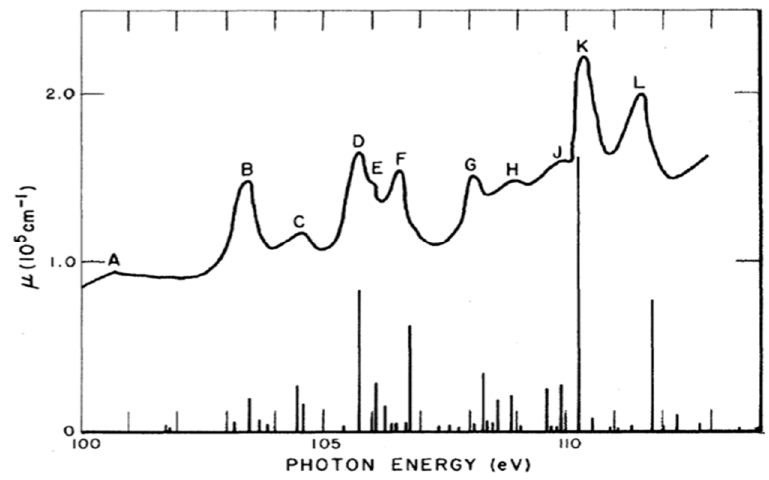
Figure 8. Here is a comparison of the measured absorption coefficient of Ce, µ (solid line) to the calculated relative positions and line strengths (histogram), in the region near the N 4,5 edge. Taken from [39]. See Reference [39] for further details. This extended peak structure is the pre-peak region described in Figure 7 and elsewhere [6,38,40,41].